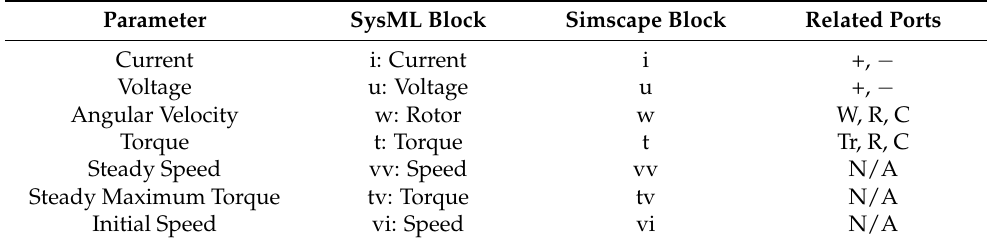
Figure 5. The appearance of the SysML block ( left ) and Simscape block ( right ) of PMSM. Table 2. Mapping relationship of internal parameters in the PMSM block.